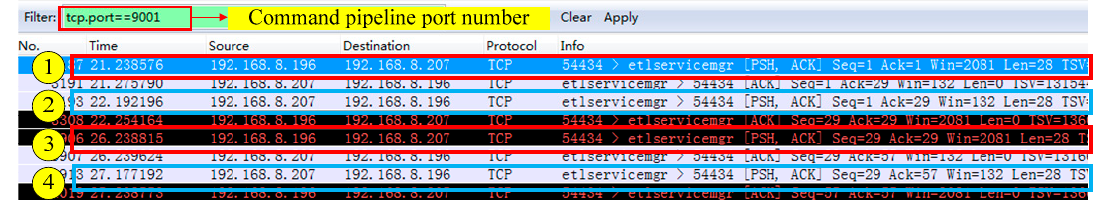
Figure 14. Remote control process message.